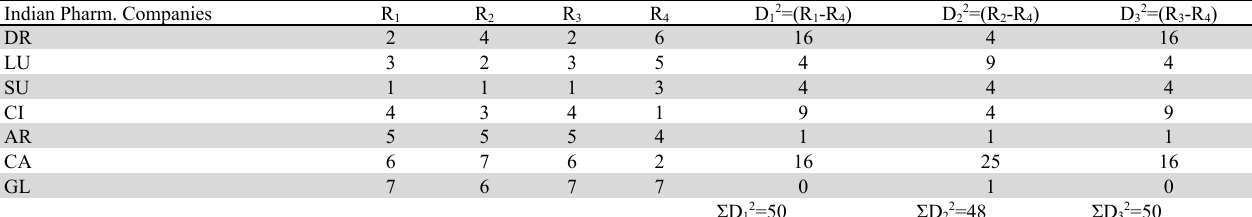
Firms' size determinants and Accounts receivables days relational co-movement Indian Pharm.